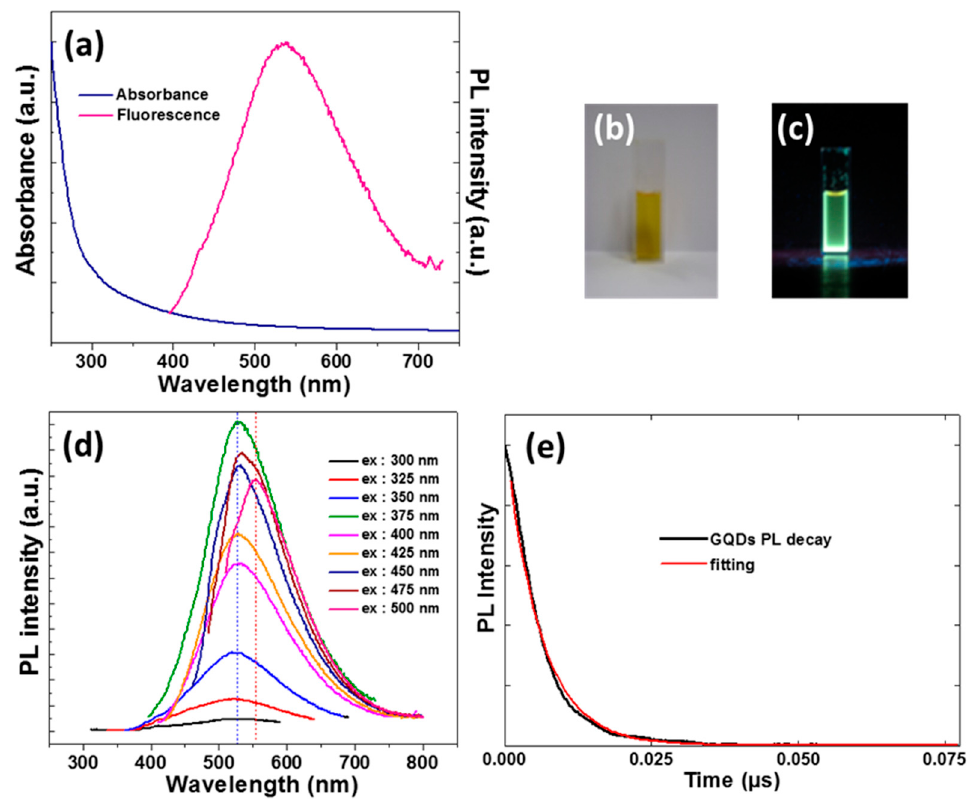
Figure 5. ( a ) UV-vis absorption and PL emission spectra of GQDs (ex = 375 nm). Photographs of an aqueous dispersion of GQDs ( b ) under room light and ( c ) under UV light. ( d ) PL emission spectra of GQDs as a function of the excitation wavelength ranging from 300 to 500 nm with an increment of 25 nm. ( e) PL decay curve of GQDs at the emission maximum (530 nm) after excitation at 355 nm.